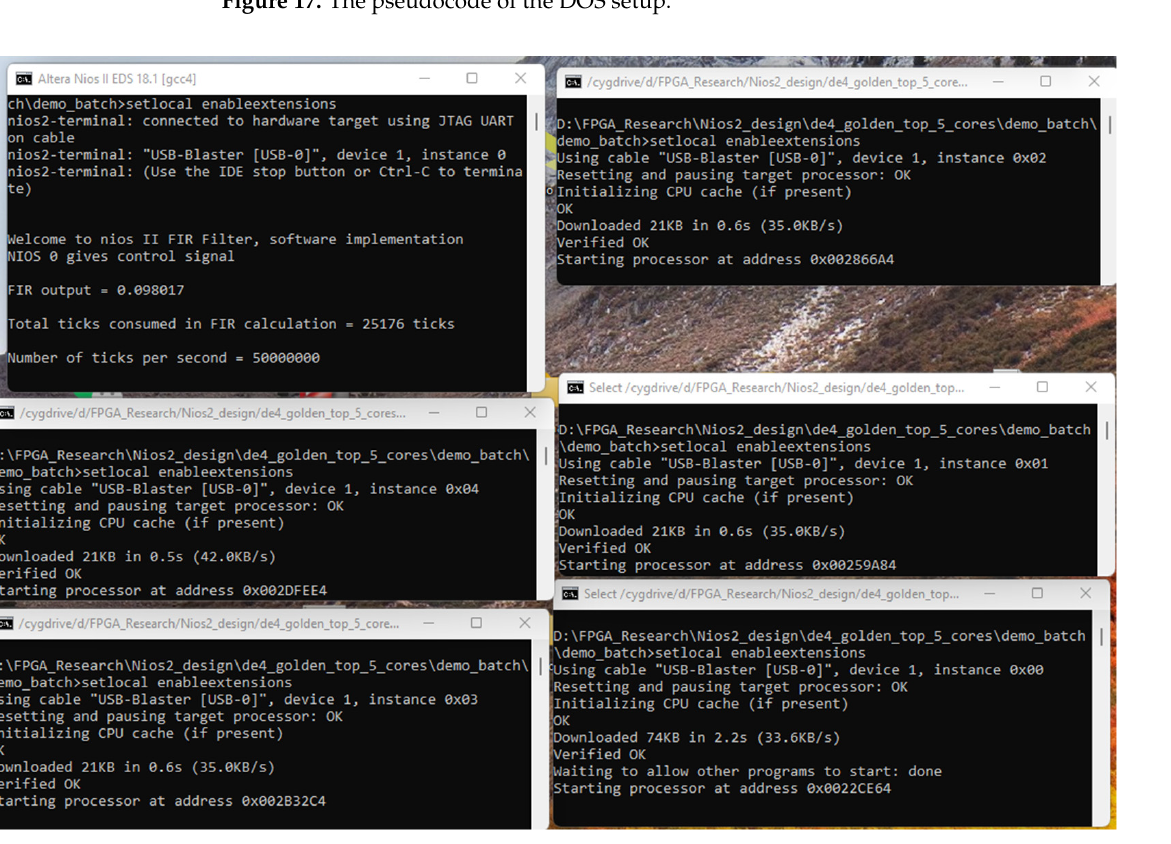
Figure 18. Terminals for a 5-core system.